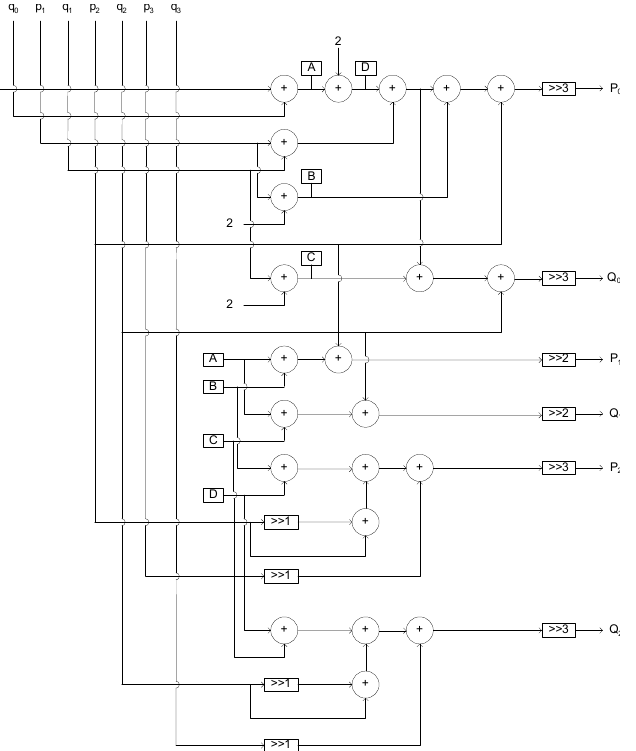
Figure 11. Resource sharing architecture of strong filter—partial